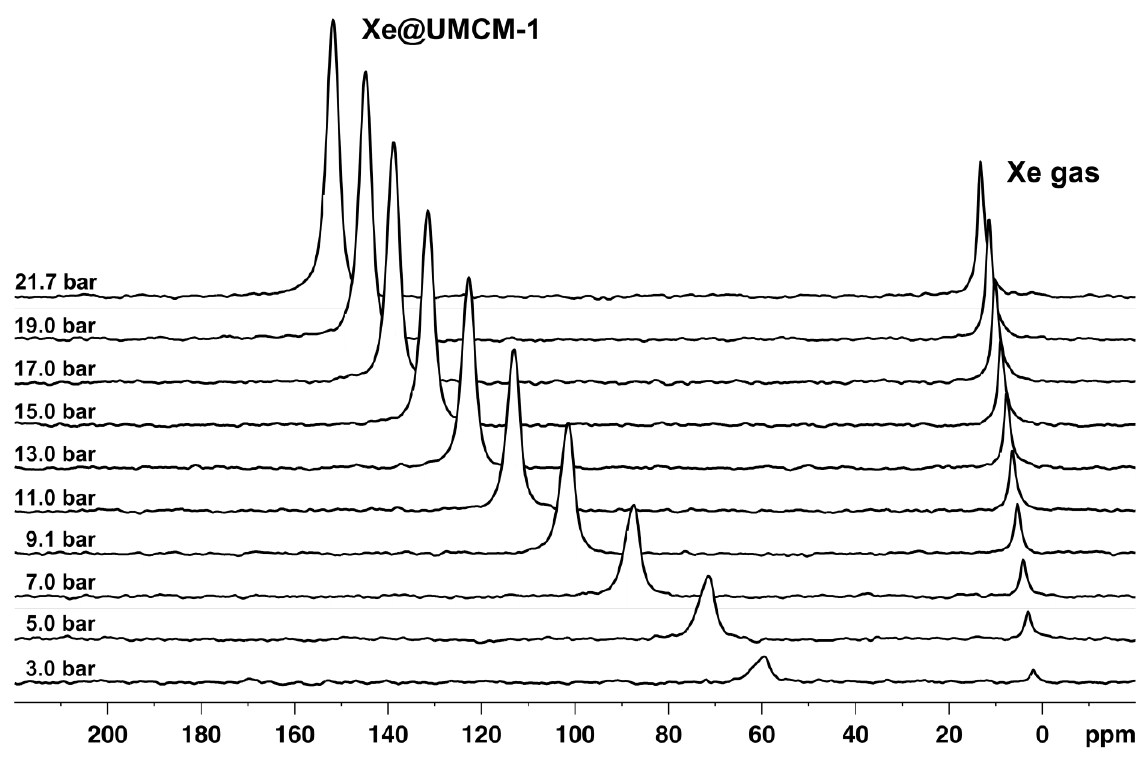
Figure 9. 129 Xe NMR spectra of xenon adsorbed on UMCM-1 measured at room temperature (RT) for various